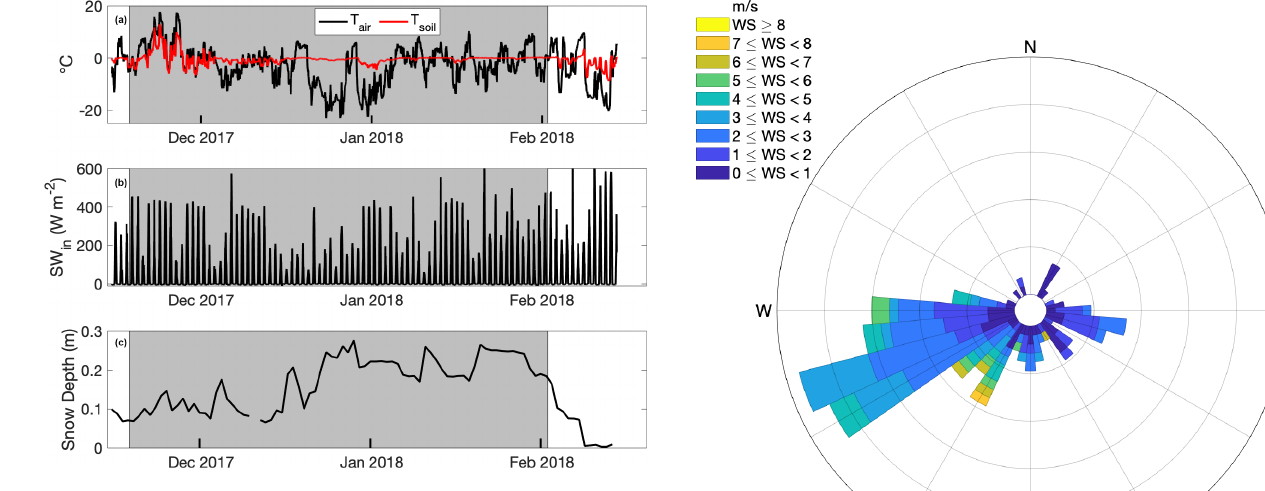
Figure 4. (a) Air ( T air ) and soil temperature ( T soil ), (b) incident shortwave radiation (SW in ), and (c) snow depth from a micromete- orological tower enclosed within an electric fence on a bison pas- ture near Gallatin Gateway, Montana, USA. Bison were present in the pasture during the interval bounded by the gray background. Figure 5. A wind rose following Pereira (2020) for periods when